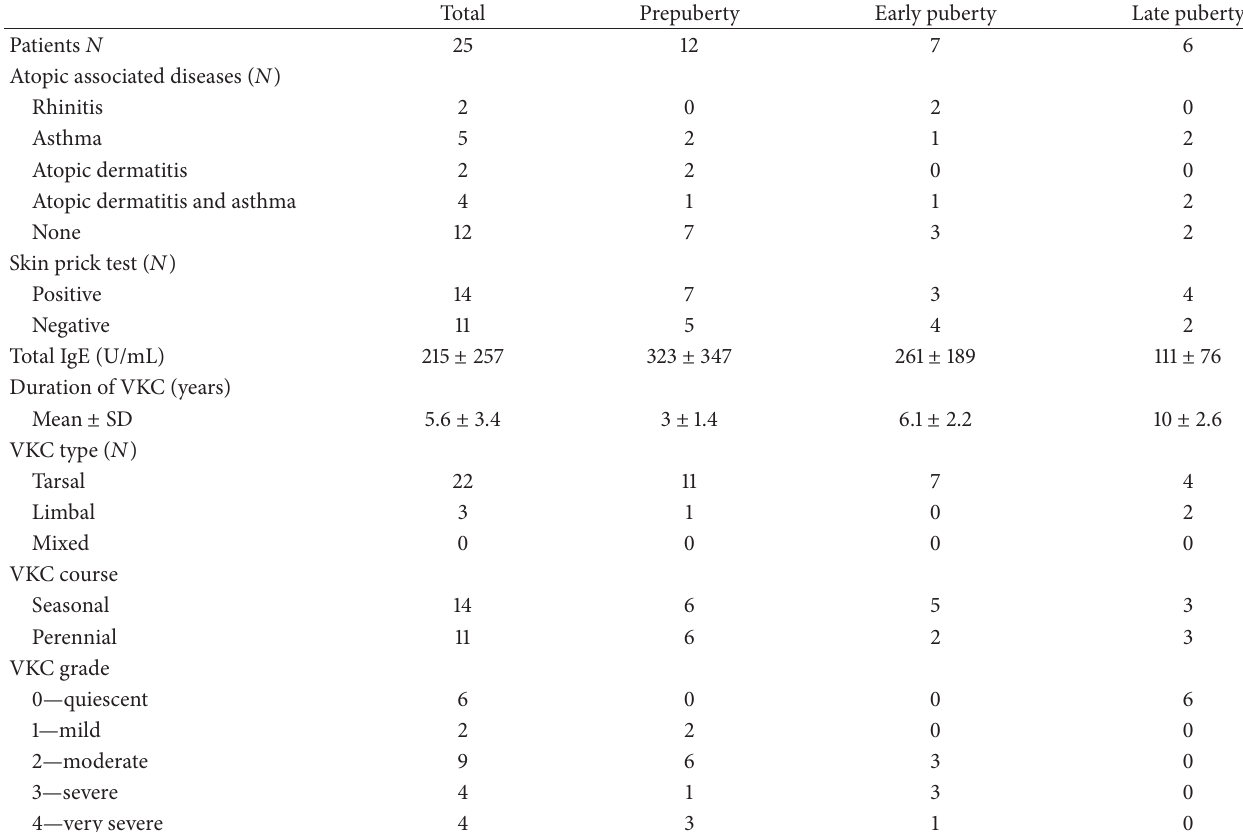
Table 1: Clinical characteristics of patients included in this